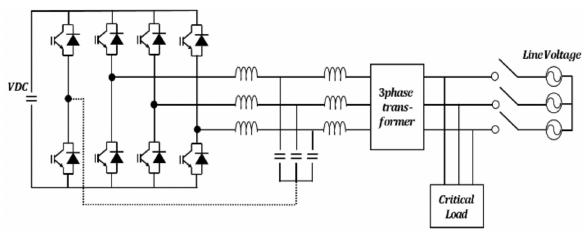
Figure 4. Three-phase four-wire PWM(Pulse-Width-Modulation)